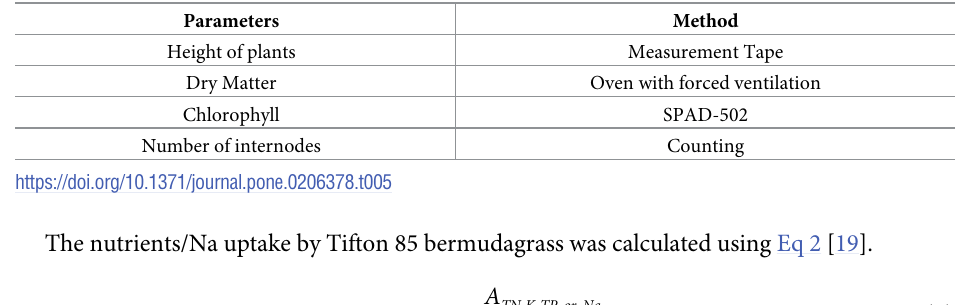
Table 5. Agronomic parameters analyzed and methods.